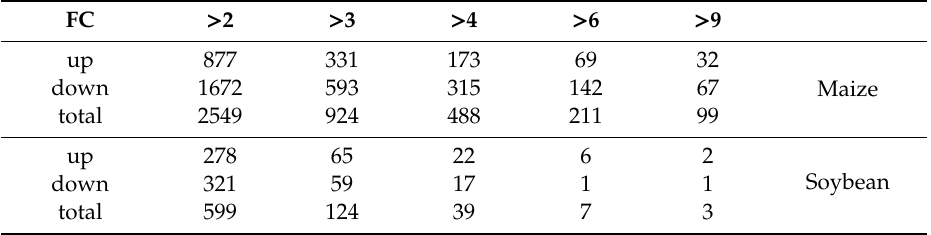
Table 1. Number of differentially expressed genes (up and down-regulated) in corn and soybean 24 h after application of formulation 52097 when compared to mock-treated control plants. FC > 2 > 3 > 4 >